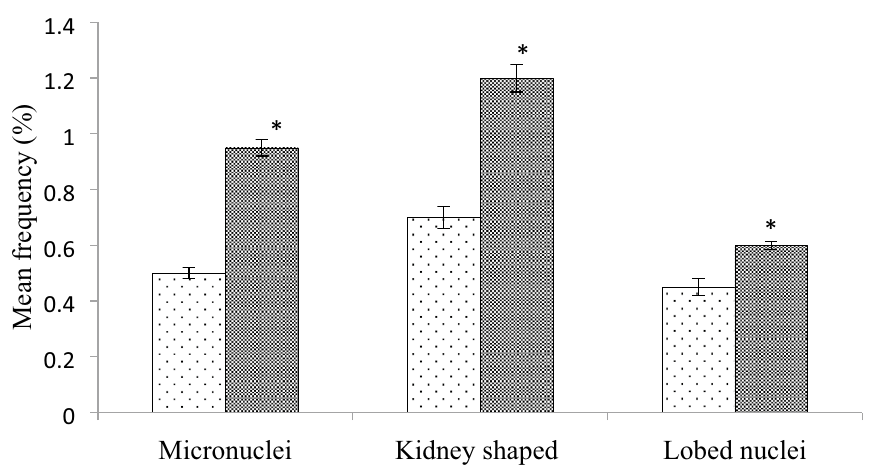
Figure 2. Mean frequencies (%) of micronuclei, kidney shaped and lobed nuclei in erythrocytes of reference and exposed O. niloticus. t-test was used for statistical analysis, significance level was established at p <